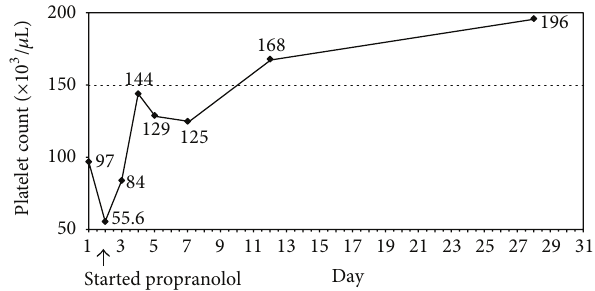
Figure 2: Course of treatment and sequential platelet count.